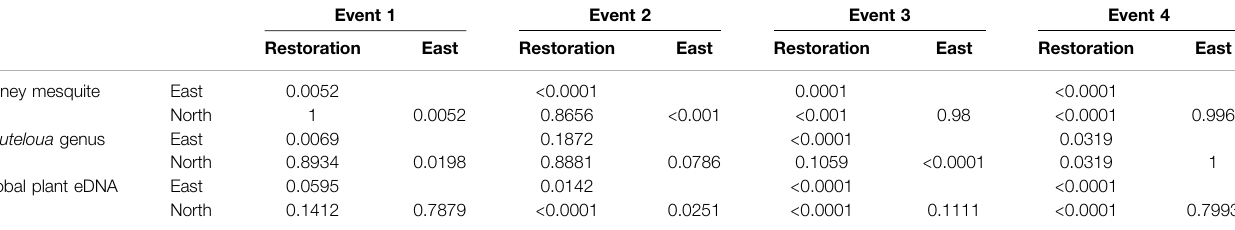
TABLE 3 | The p values for the Tukey-Kramer post-hoc comparison tests for each event examining the honey mesquite, Bouteloua genus and global plant